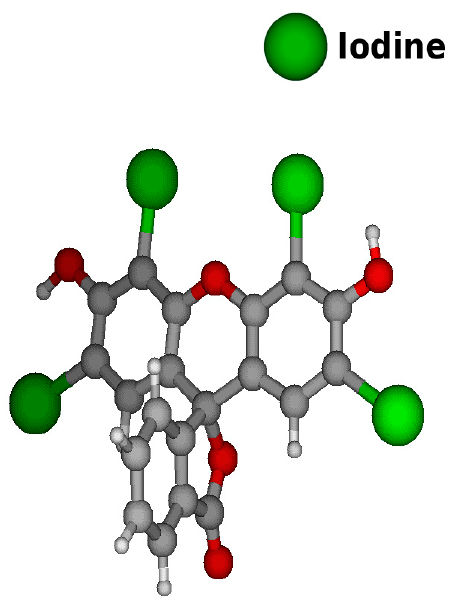
Figure 14. Ball and stick atomic model of Erythrosine. In 2014, M. Golestanch et al. [48] used a MWCNT-modified CPE. This modified elec-